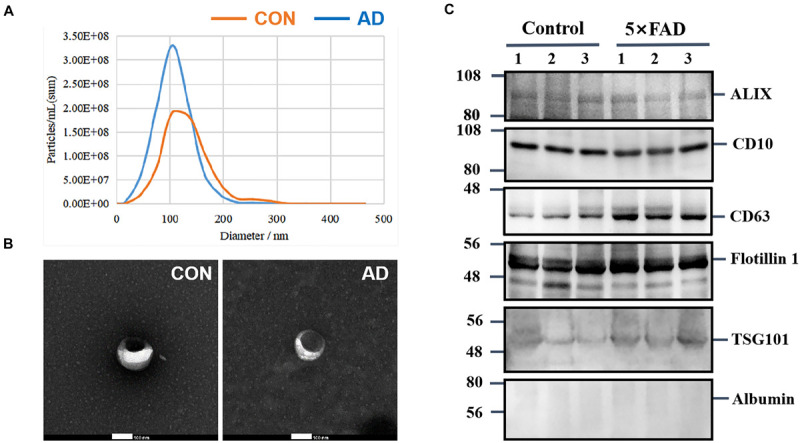
Characterization of urinary exosomes. (A) NTA of exosomes purified urinary exosomes. (B) The observation of exosomes by transmission electron microscopy (TEM). Bar = 100 nm. (C) After protein quantification, exosomes were lysed to perform immunoblot with specific monoclonal antibodies against typical exosome proteins were used to validate the quality of exosmes. Identification of Alix, CD10, CD63, Flotillin 1, and TSG101 in urinary exosomes (20 ug total protein per load) by Western blot, Albumin is a negative control protein were used to validate the quality of our isolation technique.